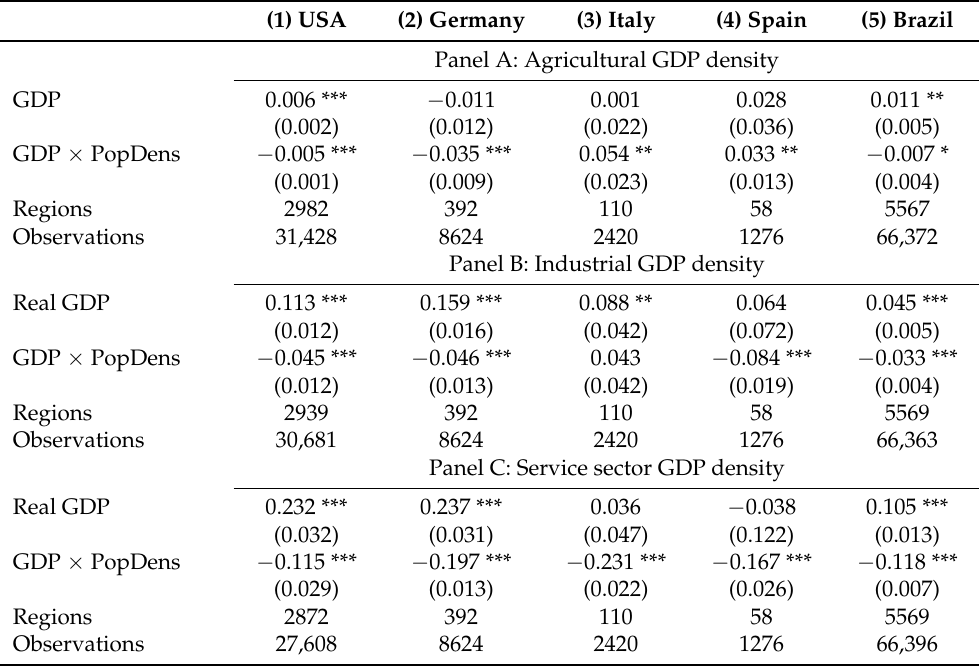
Table 5. Income elasticity of nighttime lights by population density and by economic